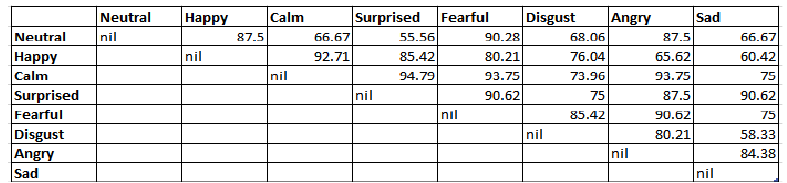
Table 2. Accuracies between pairs of emotions after using